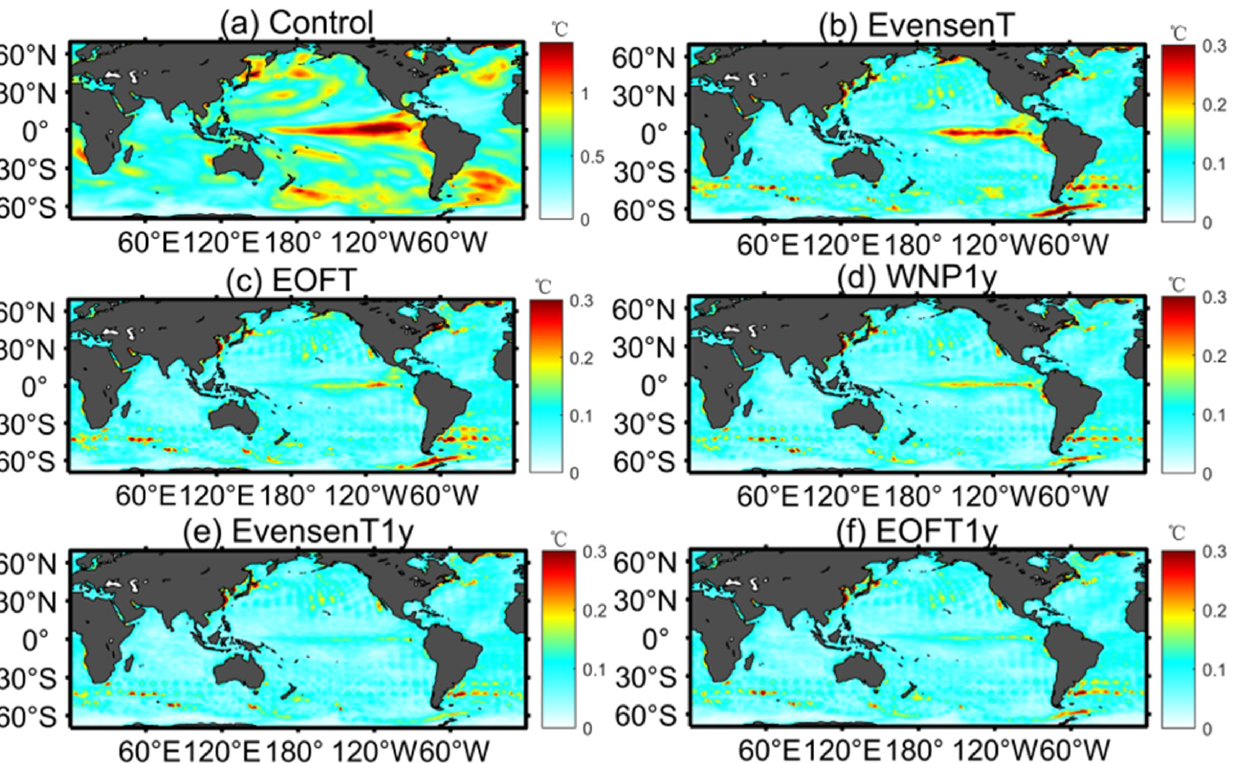
Figure 4 . The SST RMSE for ( a ) the control, ( b ) the EvensenT experiment, ( c ) the EOFT experiment, ( d ) the WNP1y experiment, ( e ) the EvensenT1y experiment, ( f ) the EOFT1y experiment (unit: °C). Although only the SST was assimilated, the results of other variables, such as sea surface salinity, also need to be examined. Figure 5 shows the comparison between assimi- lation experiments and control experiments in terms of sea surface salinity (SSS) errors. As seen in the control experiment (Figure 5a), the sea surface salinity errors in the model are mainly distributed in the western Pacific warm pool and extend to the southeastern seas, where they are as high as 0.8 psu. Such large errors also occur in the nearshore region, from uncertainties in runoff simulations, and in the high-latitude polar region, from uncertainties in sea ice simulations, but both are due to uncertainties in freshwater fluxes that lead to large SSS errors. After assimilation, the simulation of SSS improves noticeably in these areas. While the simulation of SSS has improved significantly, results of SSS demonstrate that the differences between the various assimilation experiments have begun to emerge. It is clear that in the white noise experiment (Figure 5d), there are still significant SSS